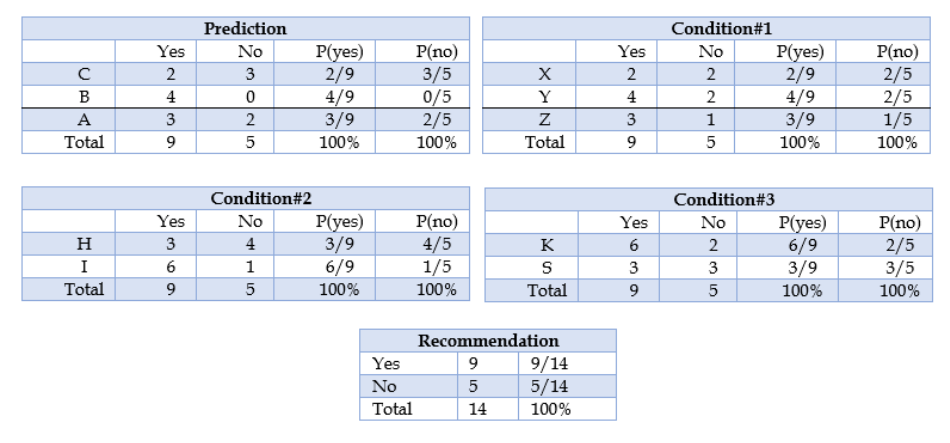
Figure 2. Probabilities of dependent feature vector with size 4.